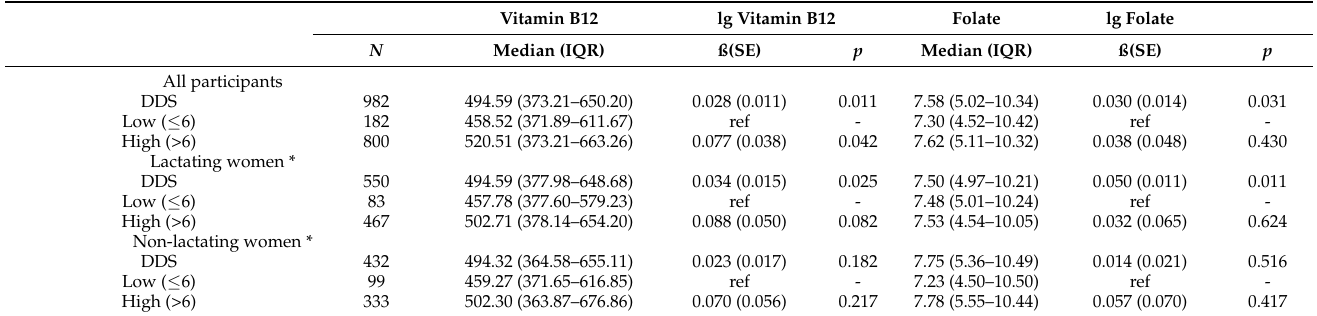
Table 4. The adjusted association of dietary diversity with vitamin B12 and folate levels by multiple linear regression